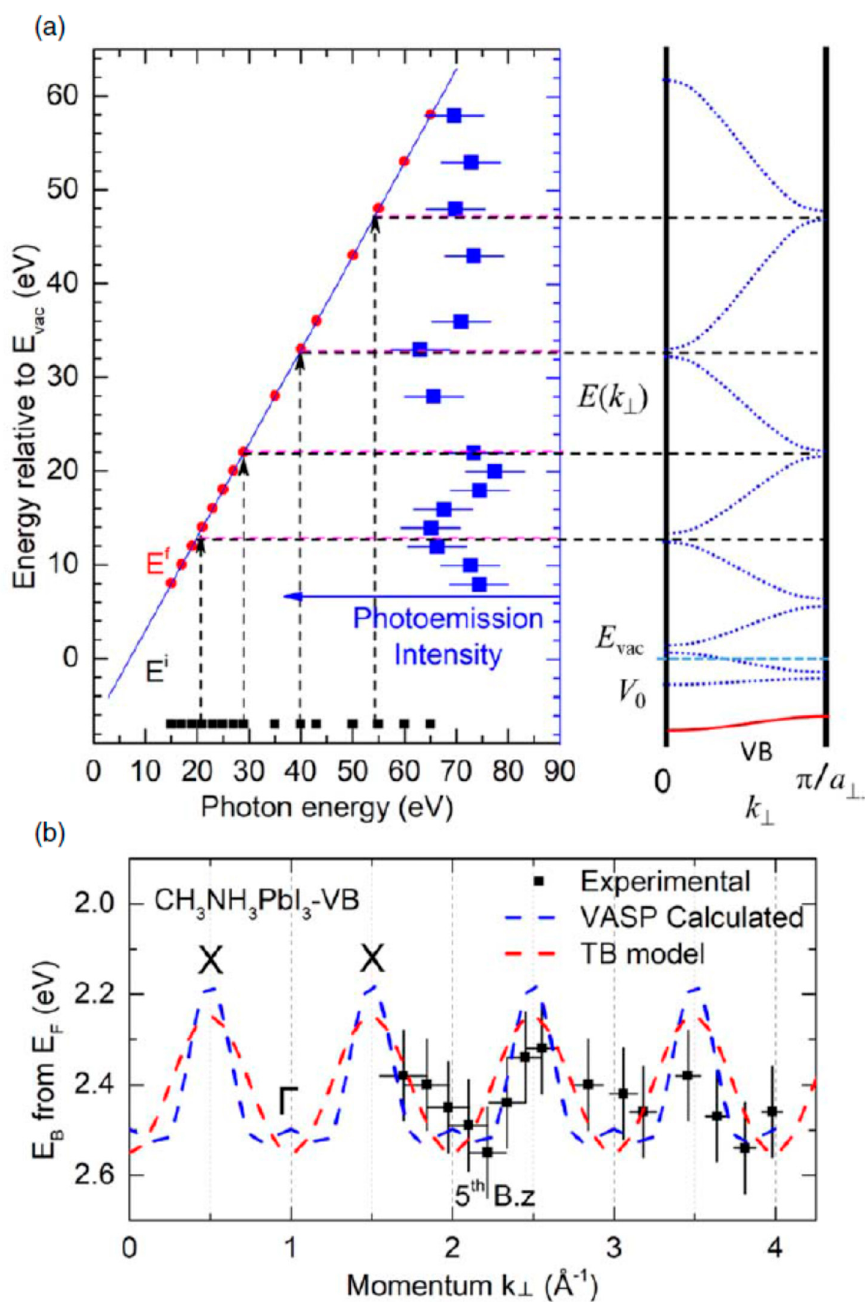
Figure 17. (Color online) ( a ) Determination of inner potential ( V 0 ) in MAPbI 3 single crystal using photon energy dependence of ARPES intensity at θ = 0. The transition from a flat band to a parabolic final state gives intensity maxima at the critical points with peaked density-of-states. ( b ) The experimental dispersion for top valence band in the extended zone scheme and the best-fit curve (dash line) under both Vienna ab-initio simulation package (VASP) calculation and the approximation of TB model with considering V 0 = − 3 eV. From Ref. [120] with permission.